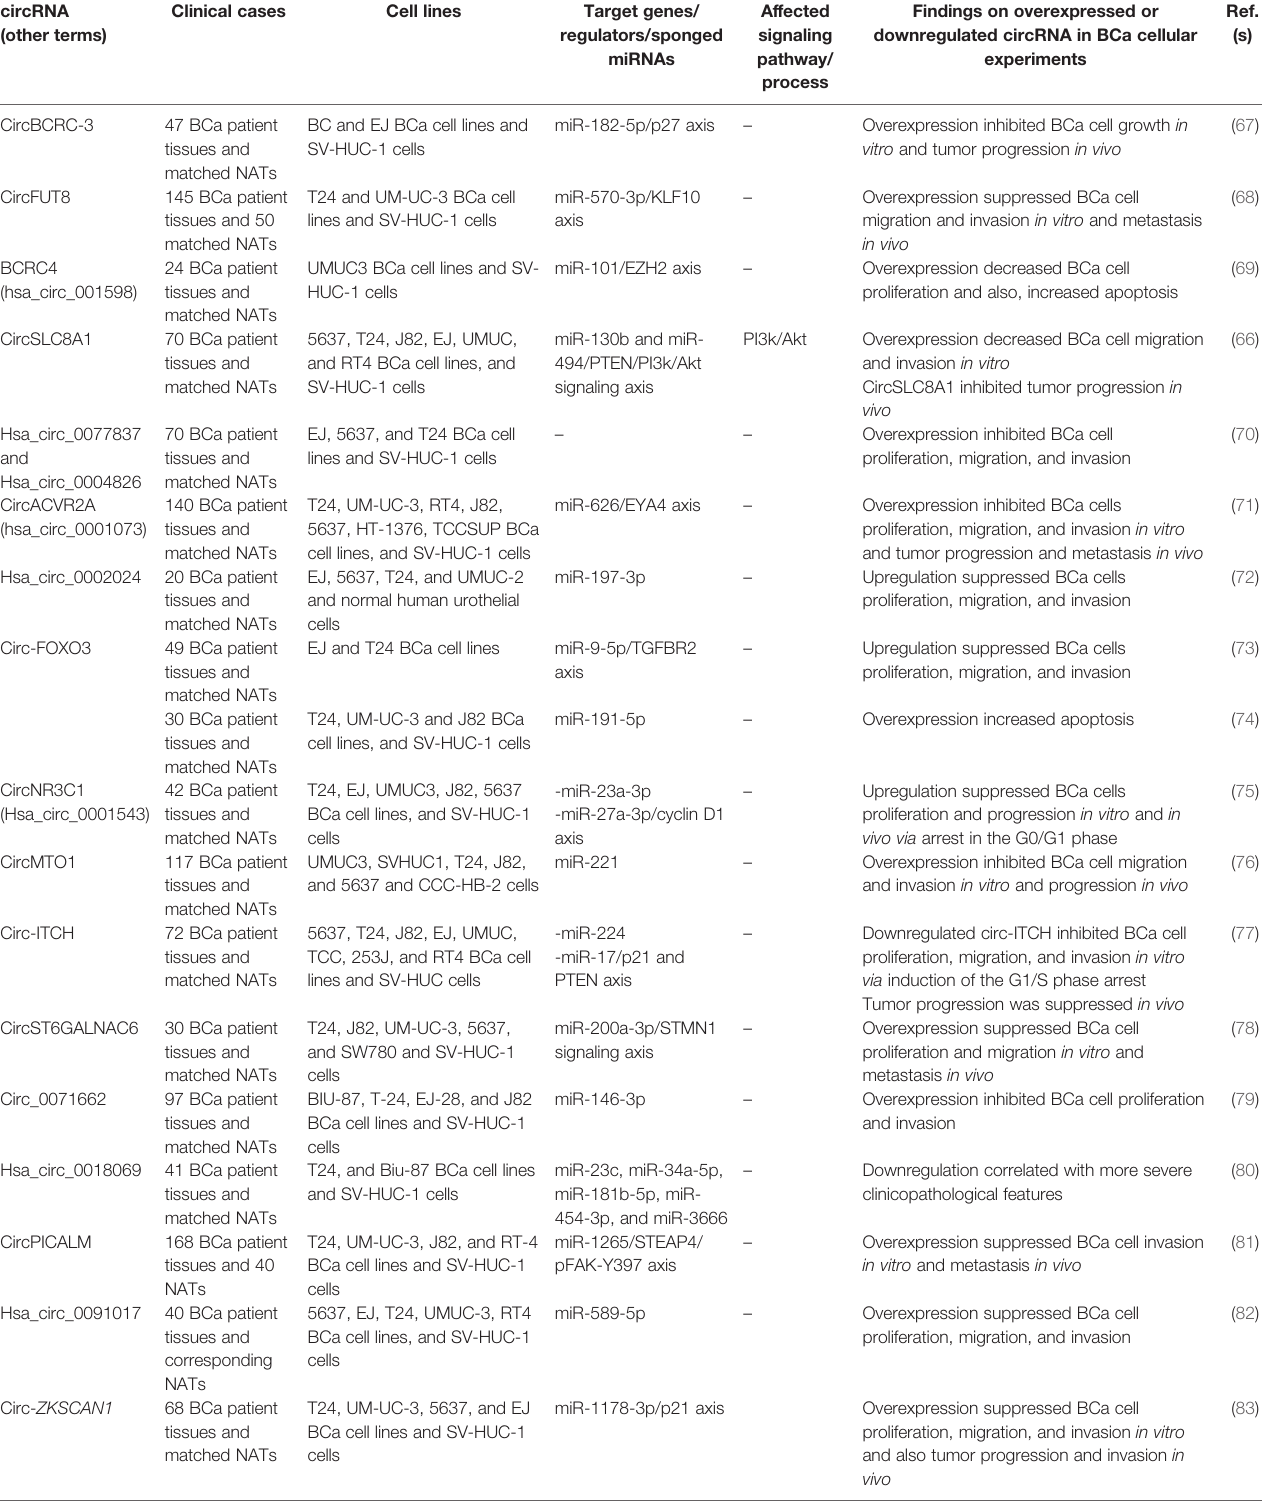
TABLE 2 | Downregulated circRNAs in